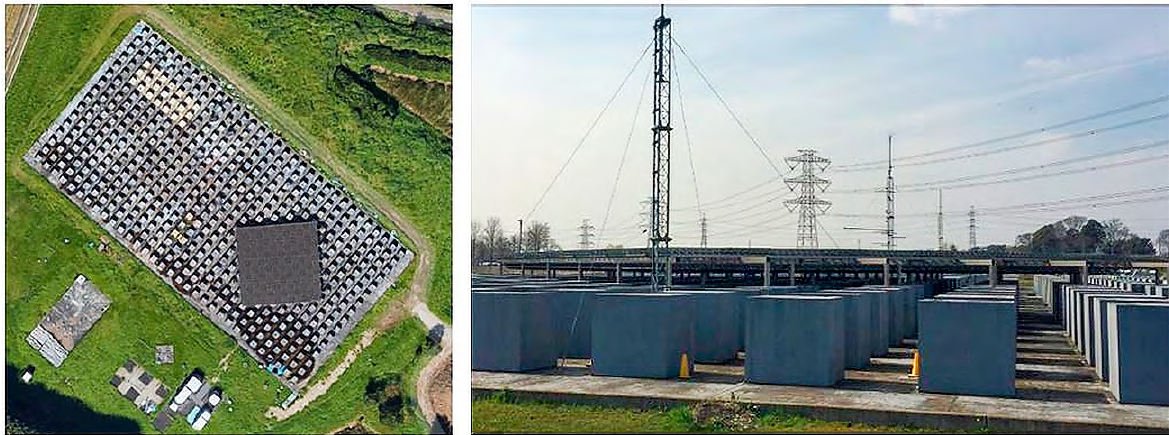
Figure 1. COSMO (Comprehensive Outdoor Scale Model), Saitama, Japan Source: https://www.google.com/earth/ (left